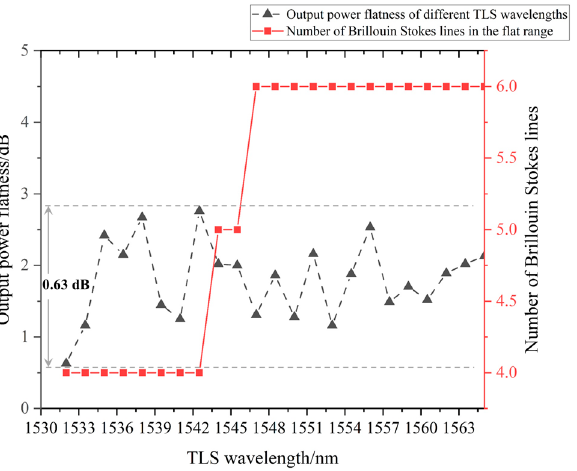
Figure 7. Output power flatness at different TLS wavelengths and the number of Brillouin Stokes lines in the entire flat range.